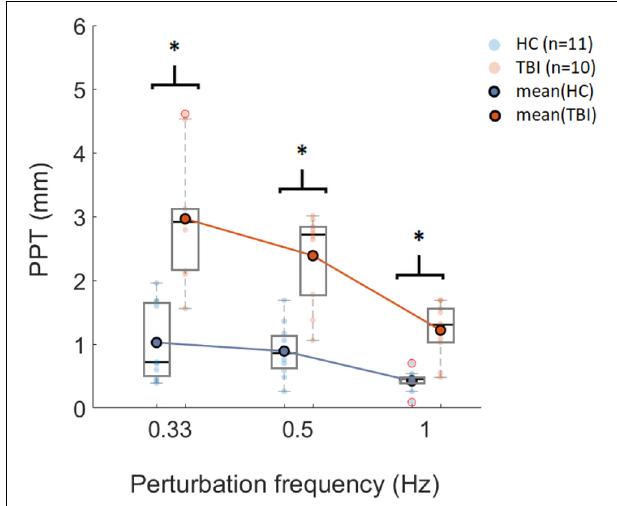
FIGURE 3 | Box plot representation of PPT values computed using SIAM for three sets of perturbation frequencies (x-axis) for HC ( n = 11) and TBI ( n = 10). Horizontal lines in each box represent the median values. Data points shown with red circles are the outliers. ∗ p < 0.006 (significance level post Bonferroni